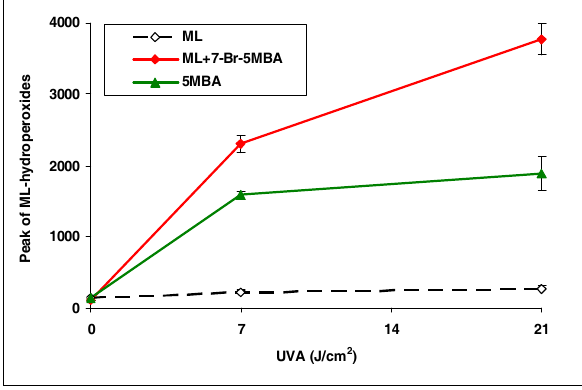
Figure 5: Peroxidation of methyl linoleate initiated by 5- methylbenz[ a ]anthracene and 7-bromo-5- methylbenz[ a ]anthracene with, 0, 7, and 21 J/cm2 of UVA light.